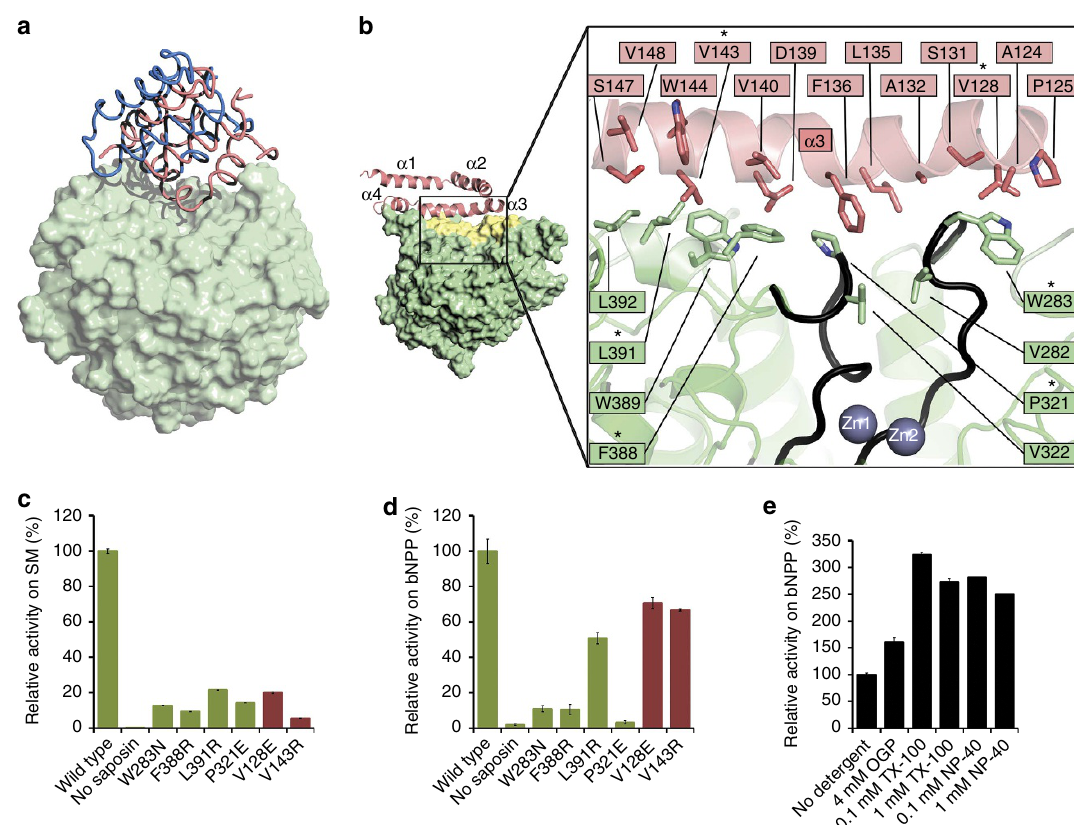
Figure 4 | ASMase sap –ASMase cat interactions. ( a ) Superposition of the two molecules in the asymmetric unit of the closed form. The reference portion for the superposition is the catalytic domain (light green surface). The saposin domains (worm representation) are shifted by roughly 8Å, and the linker connecting the saposin domain to the catalytic domain is disordered in one of the molecules (blue). ( b ) Close-up of the interface formed between open ASMase sap (pink) and ASMase cat (green). Inset: yellow shading marks the surface buried on interface formation. Active site loops in contact with the interface are coloured black. Interface mutations tested are marked by an asterisk. ( c ) Activity at pH 5 of wild type (WT) and mutants on liposomes containing sphingomyelin (SM). Bar colours correspond to ASMase cat (green) or ASMase sap (pink) mutants. Activity is normalized to WTenzyme. 100% activity ¼ 537 m M SM hydrolyzed per m M protein per h on anionic liposomes. Data are the means and s.d.’s of two independent experiments performed in triplicates. ( d ) Activity at pH 5 of WT and mutants on the small-molecule substrate bNPP. Activity is normalized to the WT enzyme. 100% activity ¼ 1.76 m M bNPP hydrolyzed per nM protein per h. Data are from two to five experiments performed in triplicates. ( e ) Effect of detergents on activity against bNPP. Data are from two independent experiments performed in triplicates. OGP, octyl- b - D -glucopyranoside; NP-40, Tergitol-type NP-40; TX-100, Triton X-100. For the latter two detergents, 0.1 and 1mM represent concentrations below and above their critical micellar